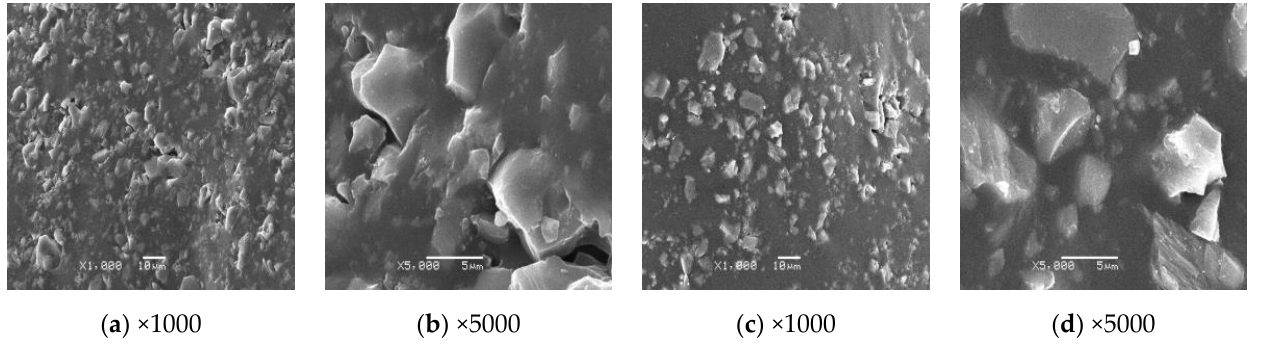
Figure 24. Scanning electron microscope images of the AR and TAR. (( a , b ): AR. ( c , d ): TAR).